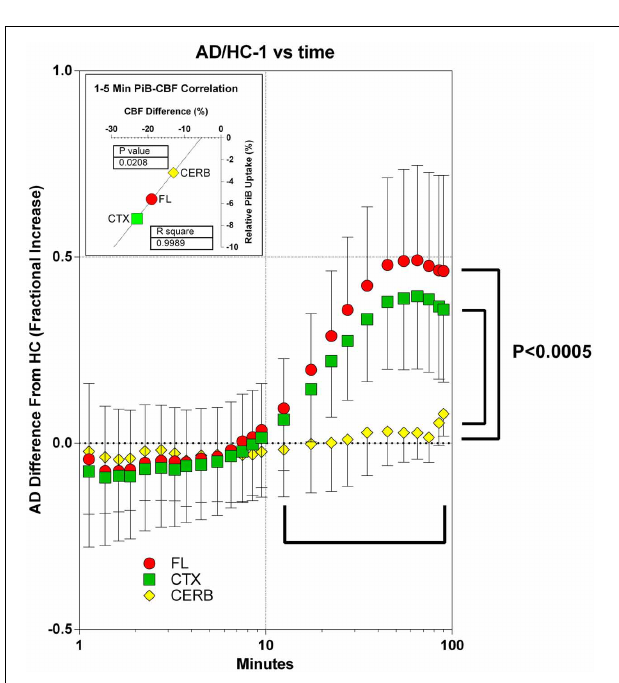
FIGURE 10 | Accumulation of [ 11 C ] PiB in brain tissue in periods of 1–10min and after 10min, in patients in relation to healthy volunteers. Abscissa: Time (minutes, log10 scale). Ordinate: Fractional difference of accumulation between patients and control subjects (ratio - 1). From 1 to 5min of circulation, brain uptake of [ 11 C ] PiB relative to healthy controls correlated significantly with the differences of cerebral blood flow ( R 2 = 0 . 999; P = 0 . 021, data not shown). After 10min of circulation among patients and healthy controls, relative uptake differed significantly ( P < 0 . 0005) for frontal lobe and cerebral cortex, but not for gray matter of cerebellum. In cortical regions, uptake of [ 11 C ] PiB in patients exceeded that of healthy controls by 40–50%, indicating binding-limited [ 11 C ] PiB accumulation in this period. For the cerebellum, the accumulation of [ 11 C ] PiB did not differ between the two